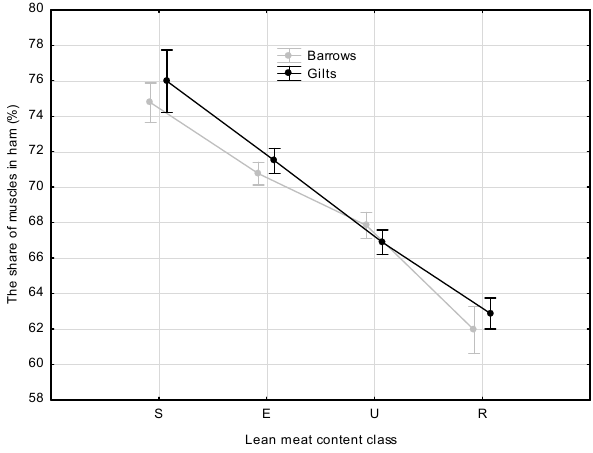
Figure 1. The percentage content of muscles in ham according to